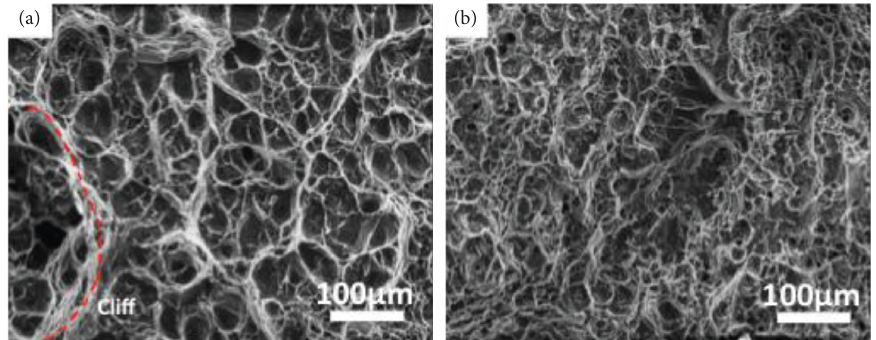
Figure 7: Fracture surfaces of toughness specimens in the crack propagation zone for (a) TL and (b) LS configurations.